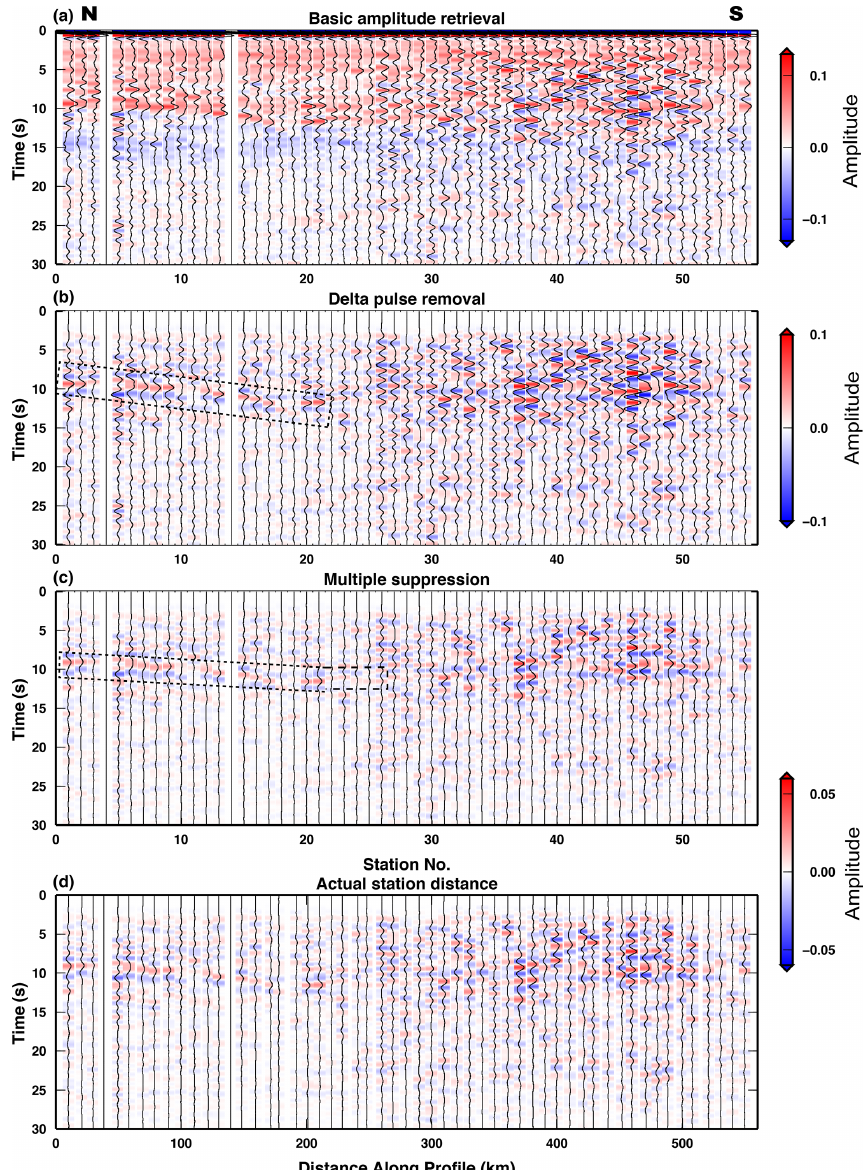
Figure 2. Steps of the GloPSI processing on the ensemble of 64 events listed in Table T1. (a) Basic amplitude retrieval, (b) delta pulse removal, (c) multiple correction and static correction, (d) amplitudes displayed according to the station distance along the north–south direction. Blue–red–blue triplet is outlined between dashed lines in panels (b) and (c) .